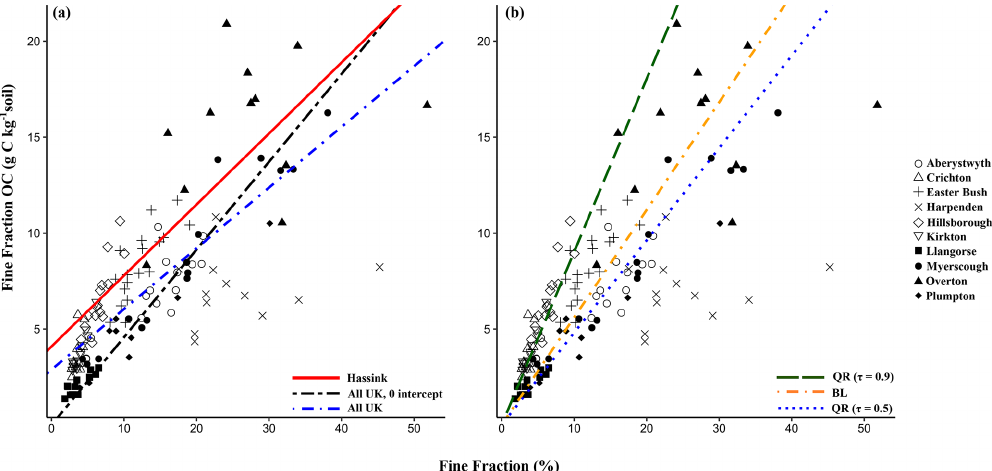
Figure 4. Measured fine-fraction organic carbon (gC per kg soil) in relation to mass proportion of the fine fraction of a soil sample (%). Lines of best fit represent the (a) linear regression method of Hassink (1997) and data from this study and (b) boundary line (BL) using 15% intervals and quantile regression analysis (QR) at the 90th and 50th percentiles. Table 5. Effect of sward age grouped at 5-year intervals on selected soil properties. Values are means ± standard error of the mean, and different letters indicate age groups which are significantly different ( p < 0 . 05), by columns. Age n C : N %SC Fine-fraction organic Fine-fraction organic carbon (gC per kg soil) carbon (% of SOC total ) 0 to 5 48 10.18 ± 0.15 a 10.00 ± 1.41 a 5.68 ± 0.49 a 18.32 ± 1.5 ab 6 to 10 18 9.79 ± 0.26 ab 11 to 15 21 + 23.21 ± 1.94